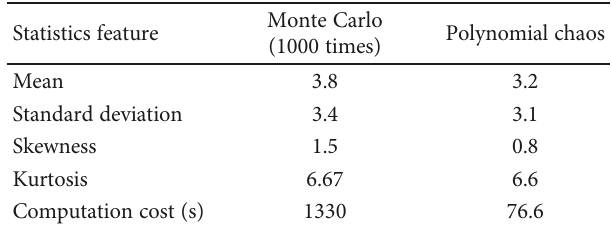
Table 5: Result of adaptive